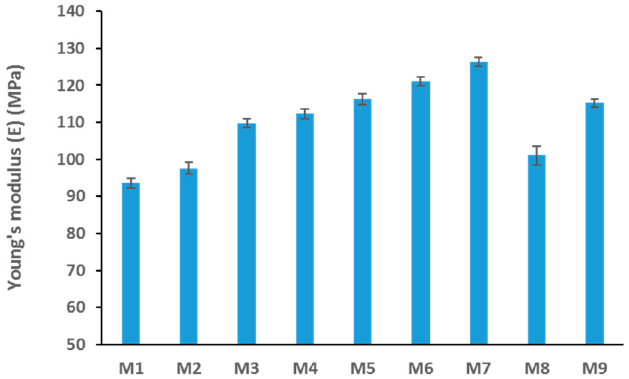
Figure 9. Average Young’s modulus values for different PES/GO membranes.